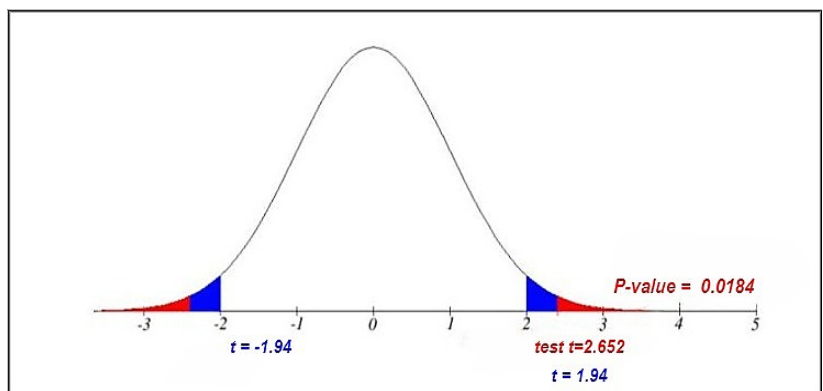
Figure 13. Paired t-test to evaluate the performance of the proposed